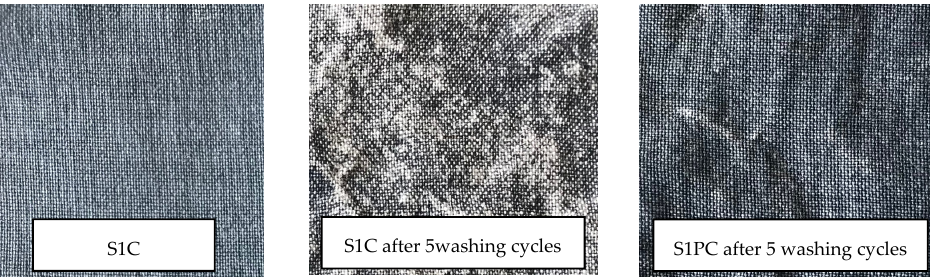
Figure 11. An appearance of coated side of fabric after washing